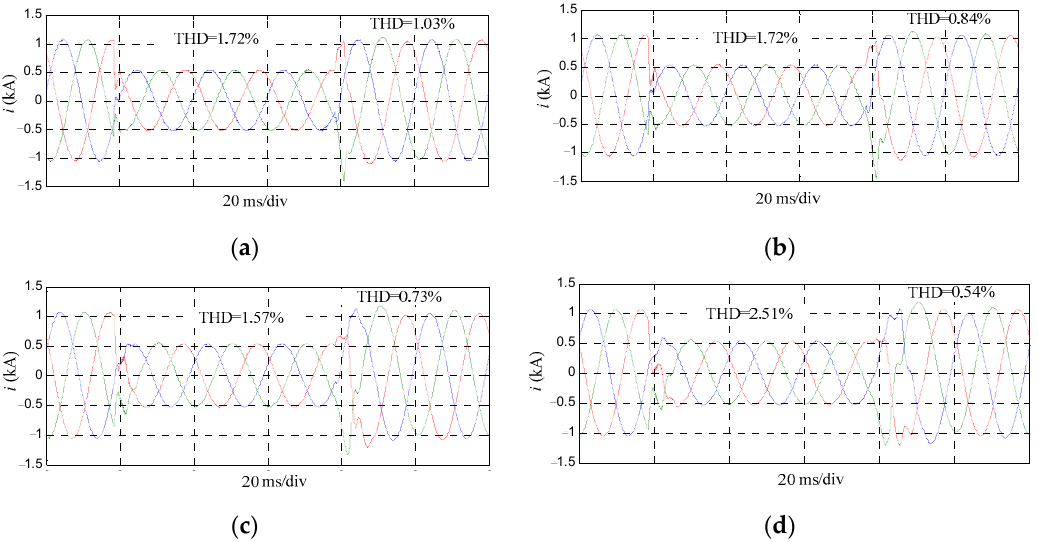
Figure 13. Simulation results of the new inverter for different SCRs. ( a ) L g = 20.4 μ H (SCR = 45). ( b ) L g = 61 μ H (SCR = 15). ( c ) L g = 184 μ mH (SCR = 5). ( d ) L g = 460 μ H (SCR = 2).